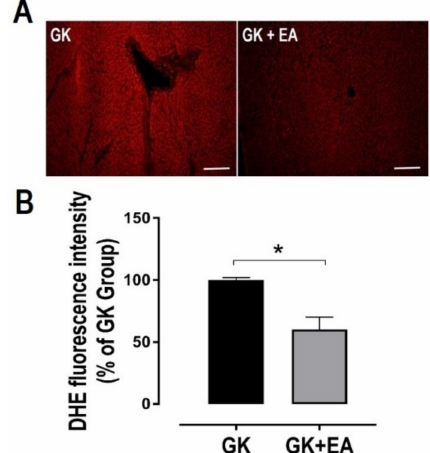
Figure 4. EA treatment reduces hepatic oxidative stress in diabetic GK rats. DHE staining was performed in frozen section of liver from diabetic GK rats with or without treatment with EA (50 mg/kg) for 45 days for detection of superoxide anion. ( A ) Representative image of DHE staining in liver section. Scale bar: 50 µ m; ( B ) Quantitative analysis of DHE fluorescence. Data are presented as mean ± SEM; * p < 0.05, ( n = 6 per group).